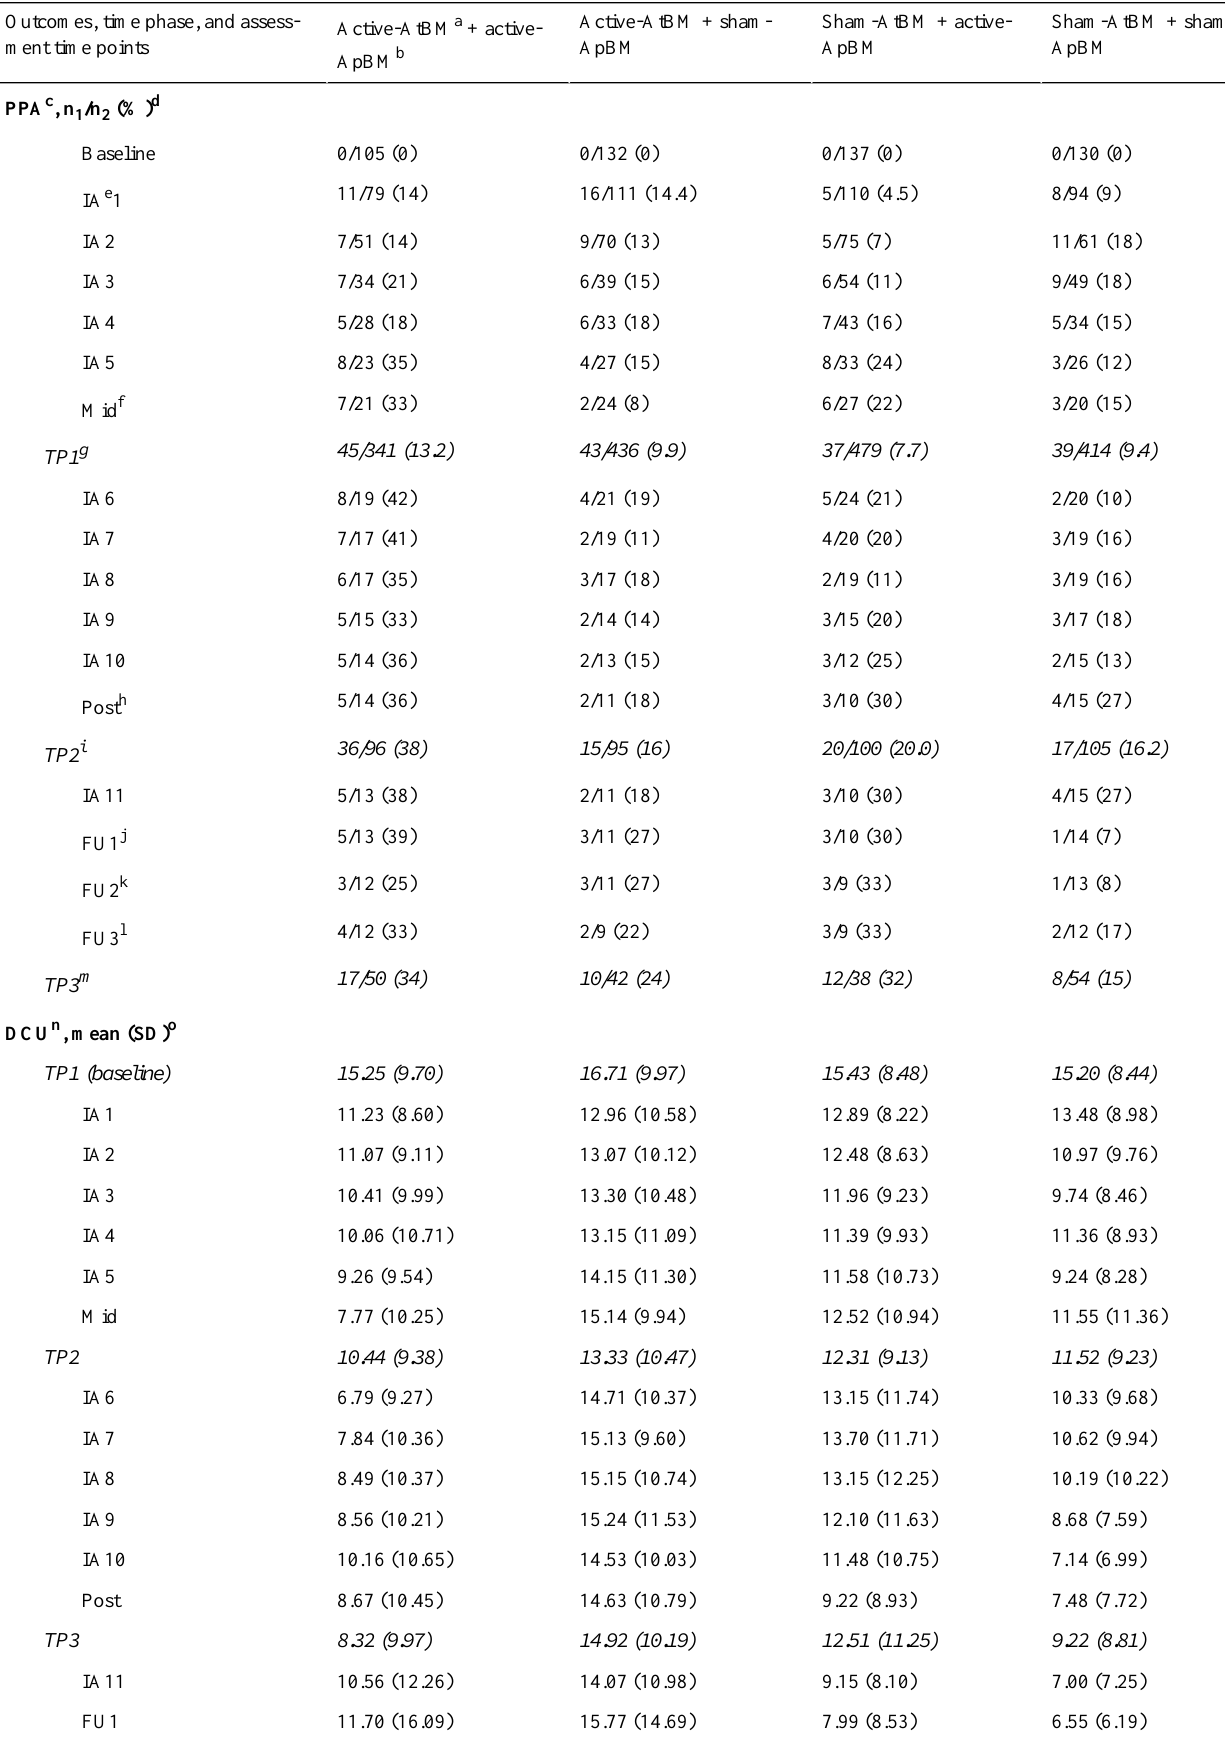
Table 3. Summary statistics on outcomes by condition, time phase, and assessment time